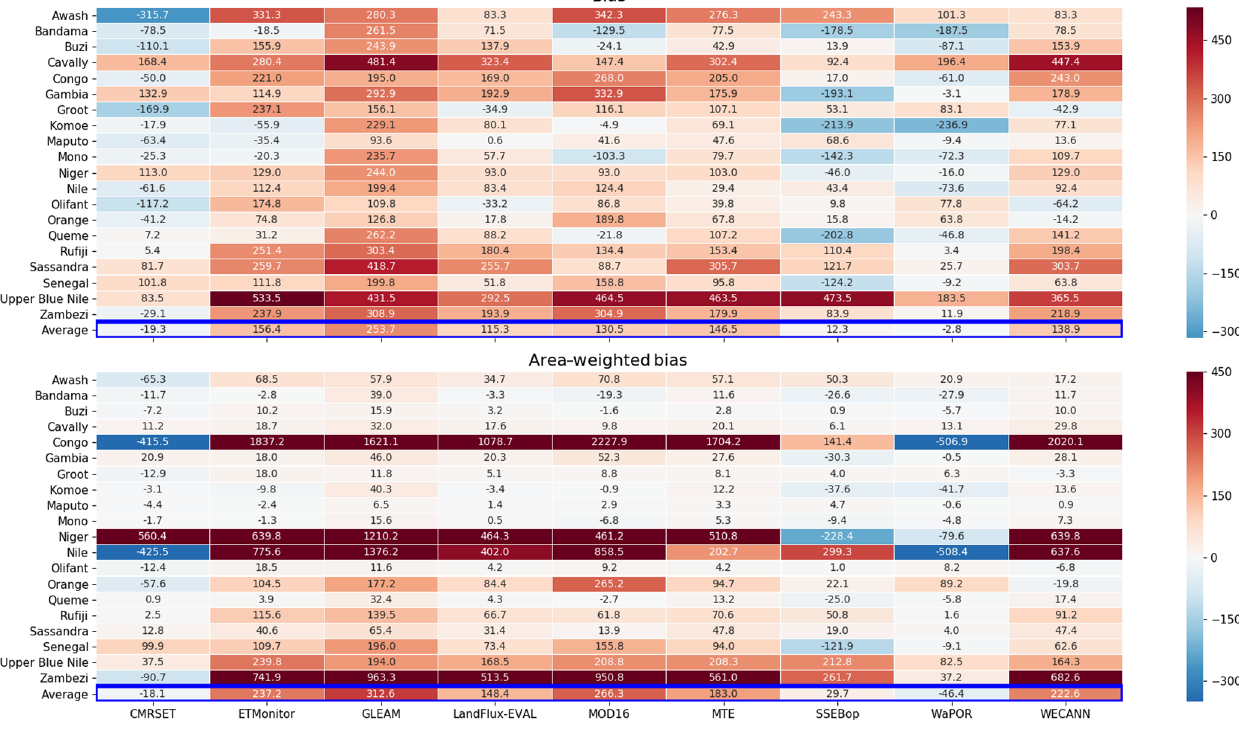
Figure 8. Bias and basin area-weighted bias between the long-term annual average calculated ET WB and ET RS for all basins and the average of the 20